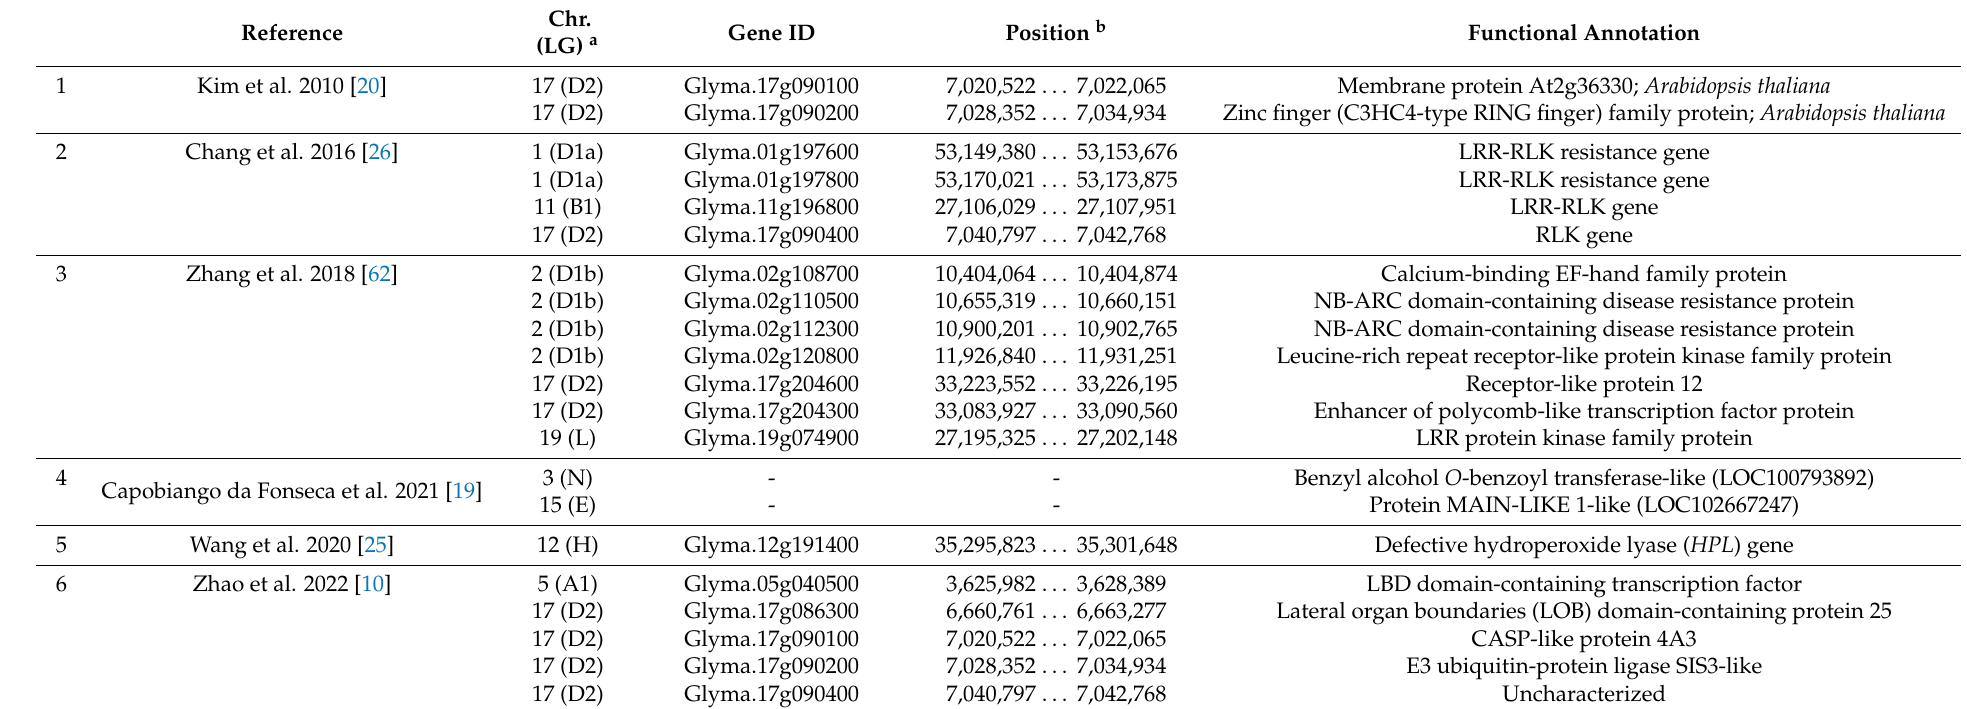
Table 3. Candidate genes for resistance to Xcg in the previous